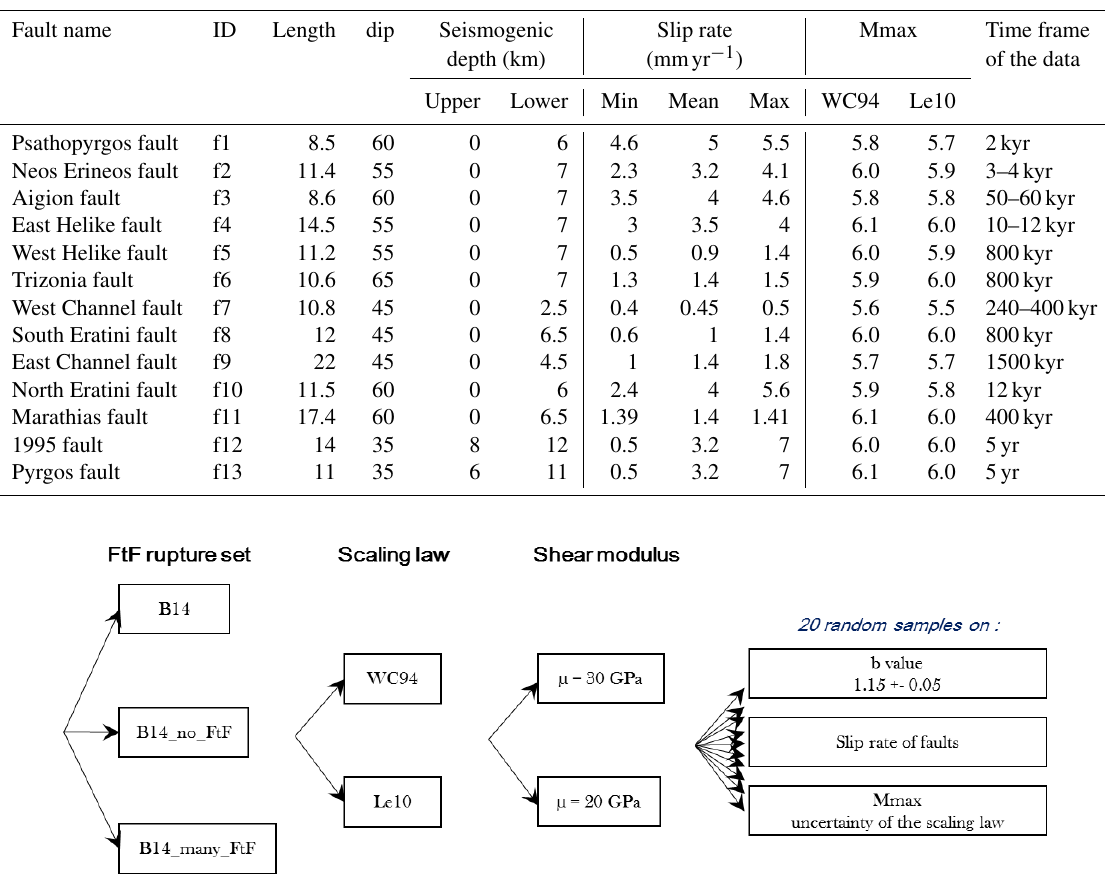
Figure 3. Logic tree explored for this